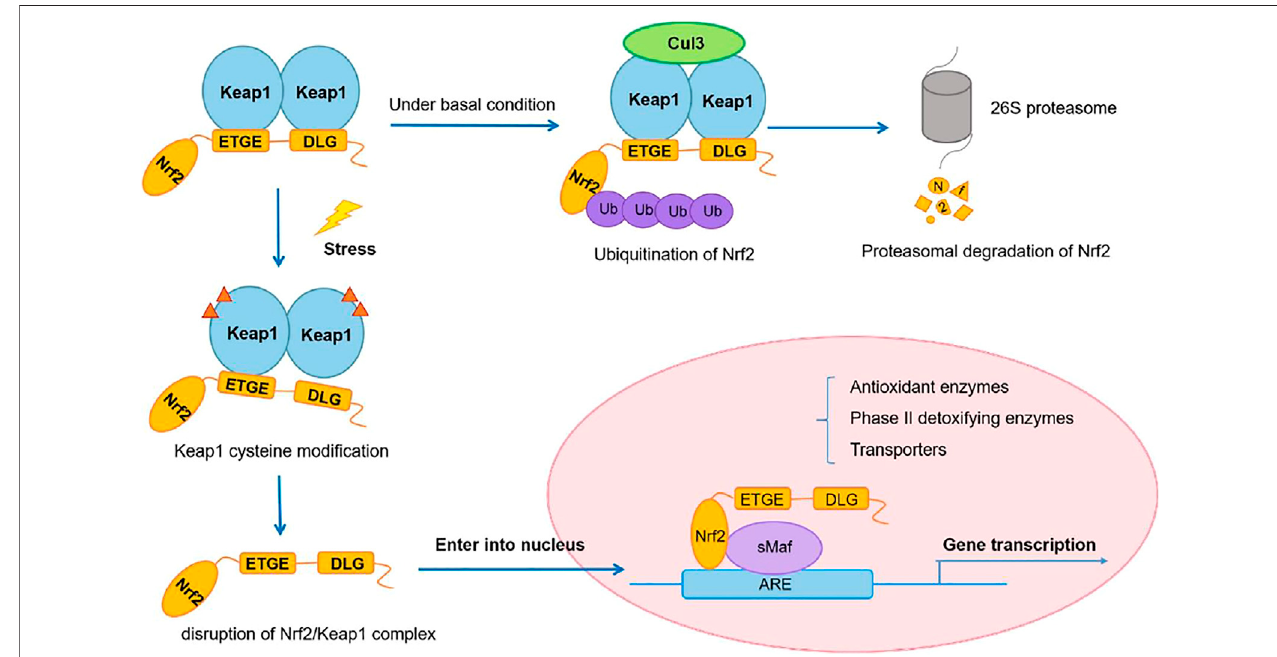
FIGURE 2 | Nrf2/Keap1 signaling pathway. Adapted from (Wu et al., 2019). Under © 2019 The Authors. Cancer Medicine published by John Wiley & Sons Ltd. https://creativecommons.org/licenses/by/4.0/.